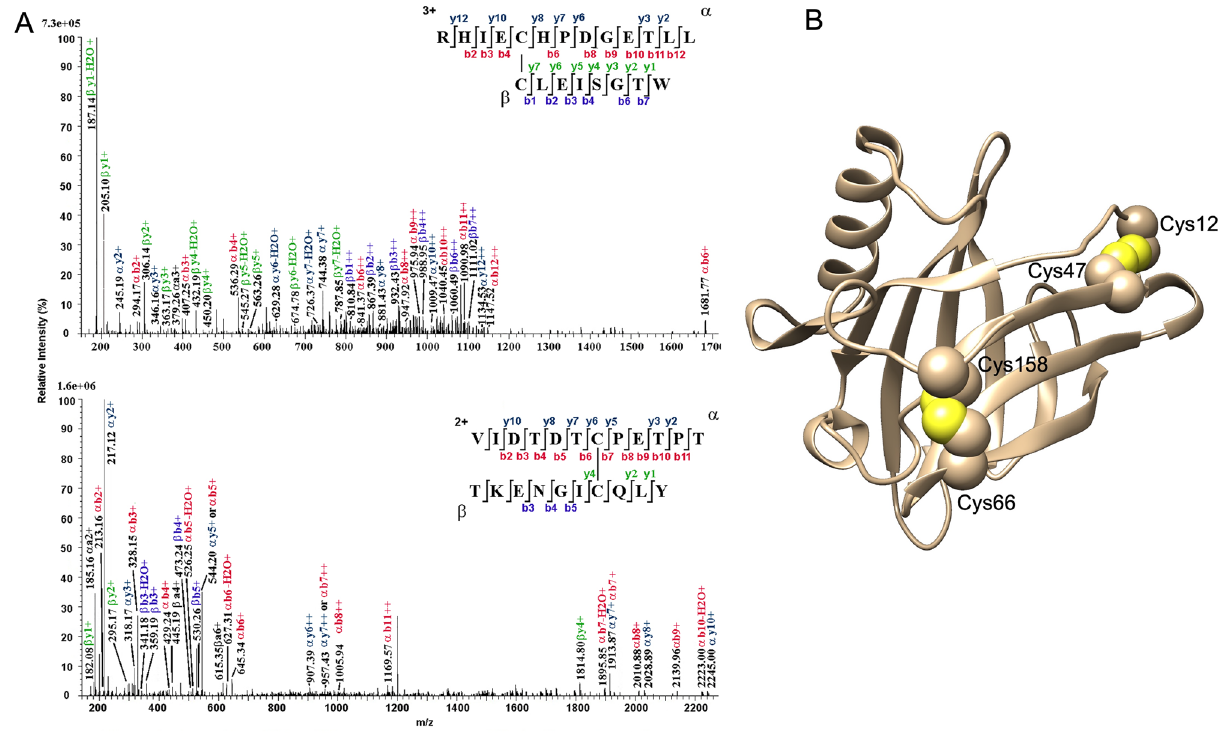
Figure 4. ( A ) Fragmentation spectra of disulfide-bridged peptides identified in the tryptic-chymotryptic digest of recombinant LafrOBP1. The upper and the lower panels show independent data relative to Cys12-Cys47 and Cys66-Cys158 disulfide bridges. The fragment ions are reported in different color depending on the peptide present in S–S-linked species, and corresponding b and y ion series. ( B )Three-dimensional model of LafrOBP1 showing the pairing of the four cysteines. The model was generated with the on-line software Swiss Model using the structure of the allergen Bosd2 (PDB: 4WFU.1.A) as a